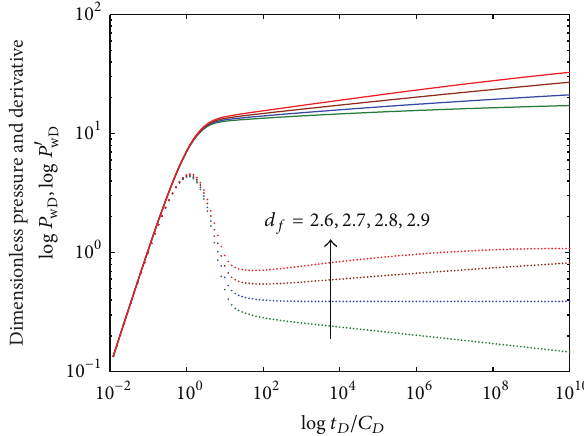
Figure 3: Effect of 𝐶 𝐷 for the type curves of the fractal reservoir with spherical flow.